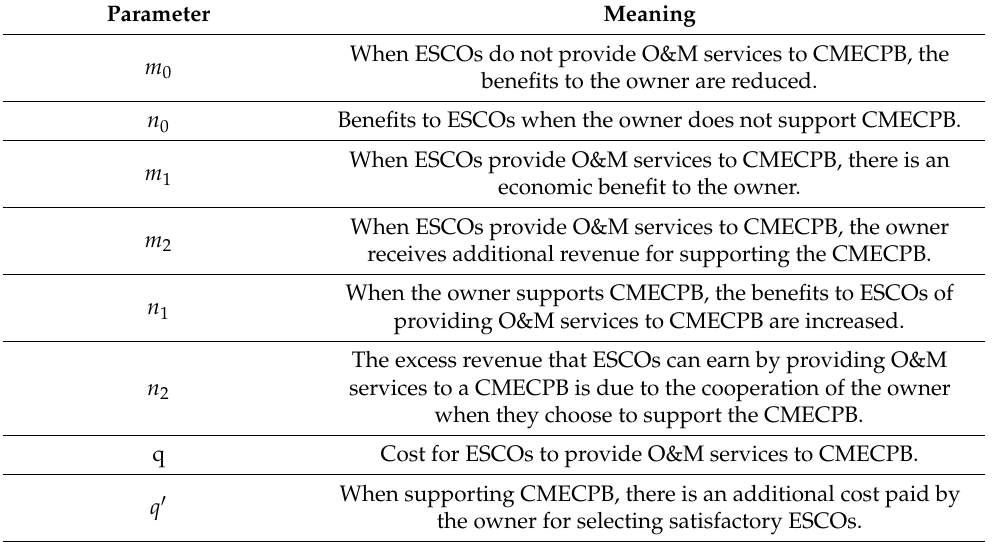
Table 1. Model parameters and